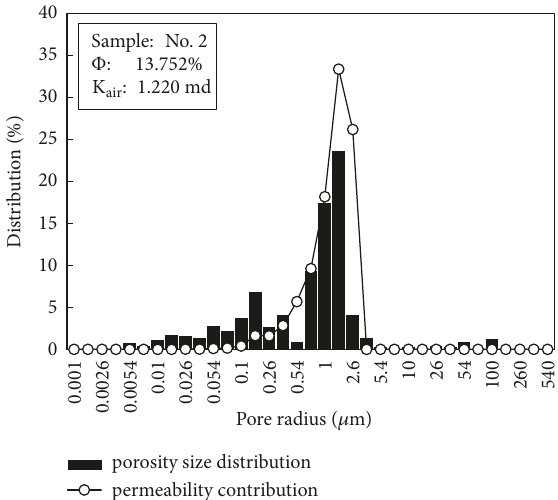
Figure 12: The distribution of pore volume and permeability contribution of the no. 2 core sample.